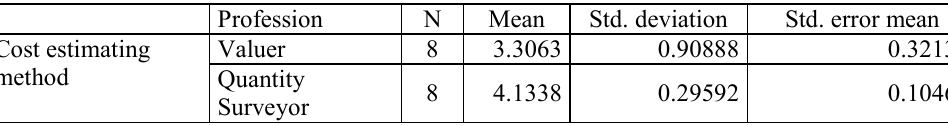
Table 3. Descriptive Statistics on Level of Expertise in Cost Estimating Methods between Valuers and Quantity Surveyors (developed by the authors) Profession